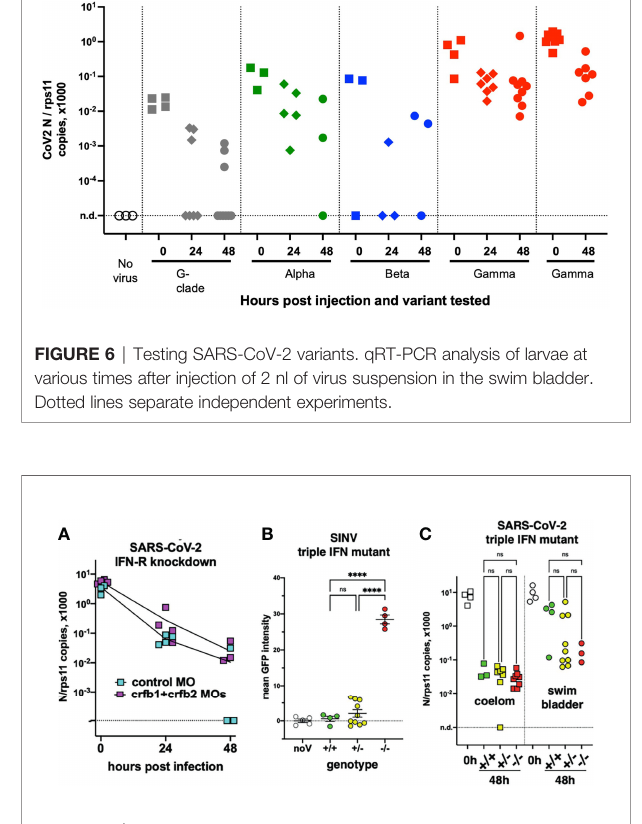
FIGURE 7 | Viral infection inIFN-defective larvae. (A) IFN-receptor(crfb1and crfb2genes) orcontrol morphants infected at 3 dpf inthe coelomiccavity; qRT-PCR. (B, C) Offspring from an incross of heterozygous triple IFN-mutants. (B) Larvae injected with SINV-GFPIV at 3 dpf, analyzed by fl uorescence imaging at 48 hpi. (C) Larvae injected with SARS-CoV-2, either at 3 dpf inthe coelom or at 4 dpf in the swim bladder;analyzed by qRT-PCR at 0 or 48 hpi.Statistical analysisby ordinary1-way ANOVA in (B) , byKruskal – Wallistest in (C) . ns, not signi fi cant; ****p < 0.0001.